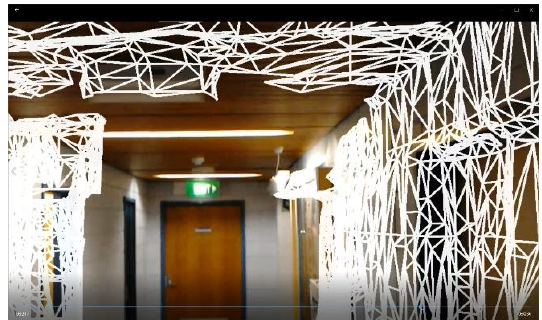
Figure 2. Mixed reality view of the 3D mesh captured by the